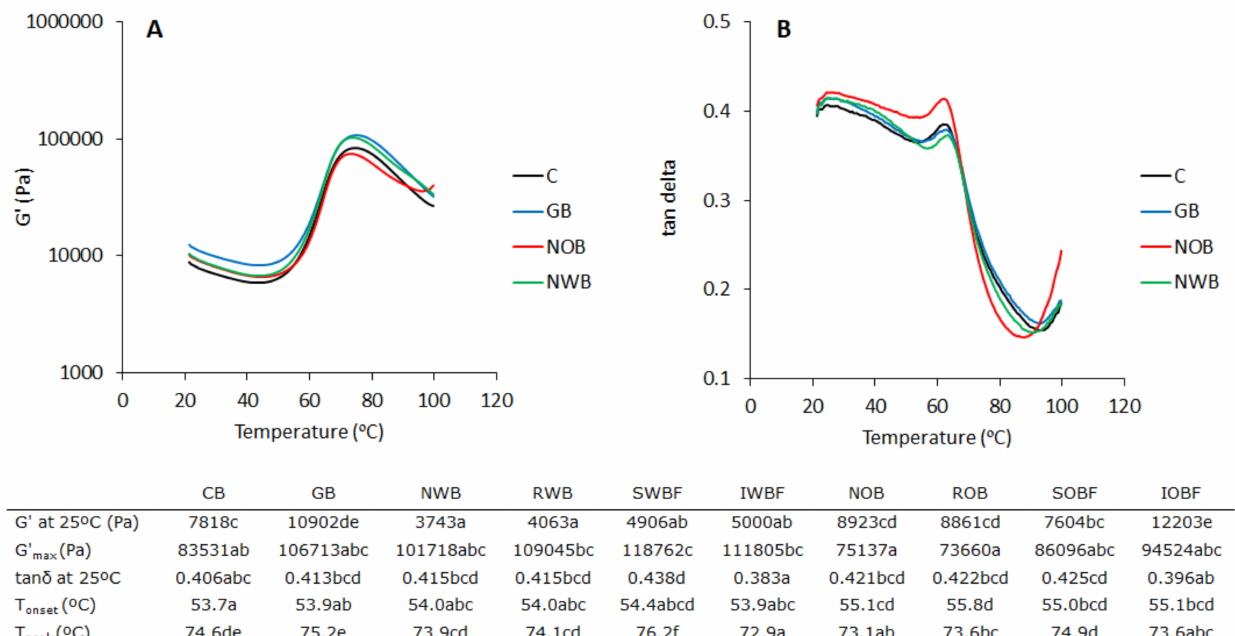
Figure 3. Examples of DMTA profiles for wheat dough enriched with glass beads and native wheat (NWB) and oat (NOB) brans showing the evolution of G’ and tan δ as a function of temperature. The table shows the parameters extracted from the curves for all dough variations. Different letters in the same row indicate statistically significant differences ( p < 0.05). Sample abbreviations are reported in Table